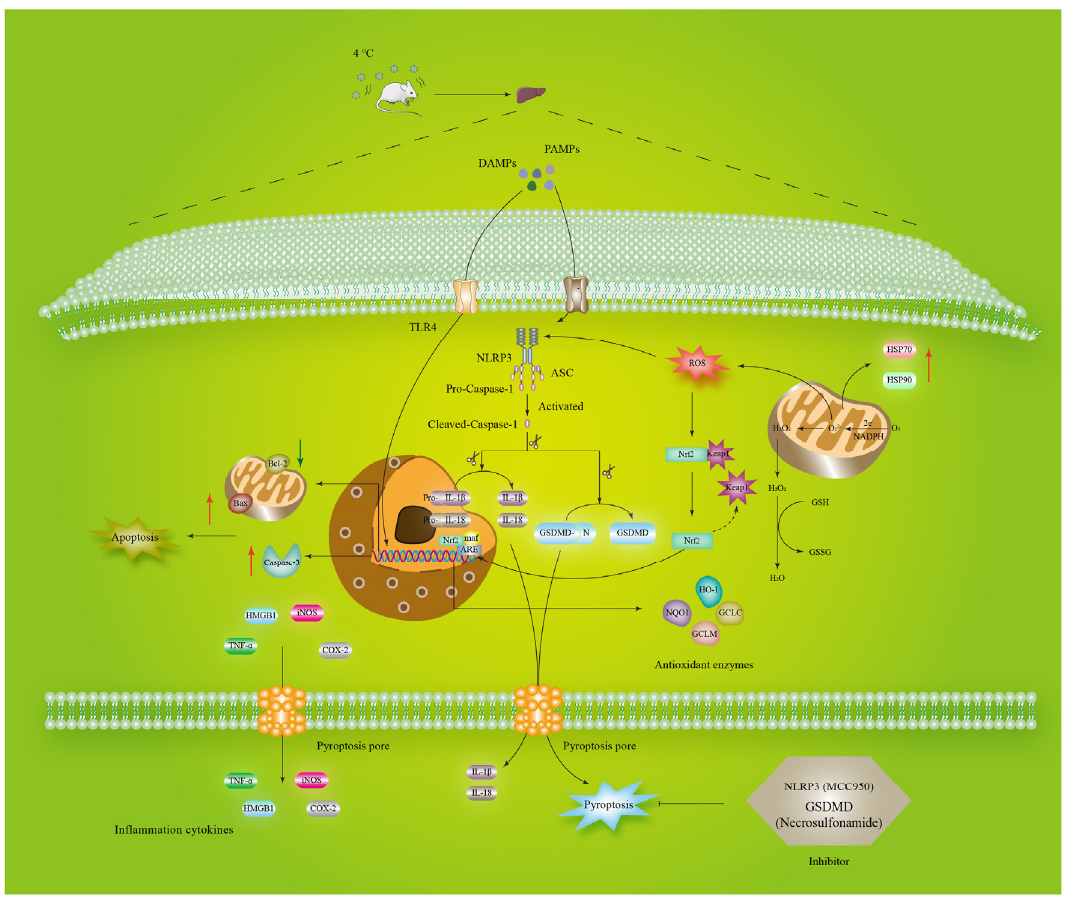
Figure 9. A proposed model for molecular mechanisms involving pyroptosis signaling pathway related to cold stress in the liver of